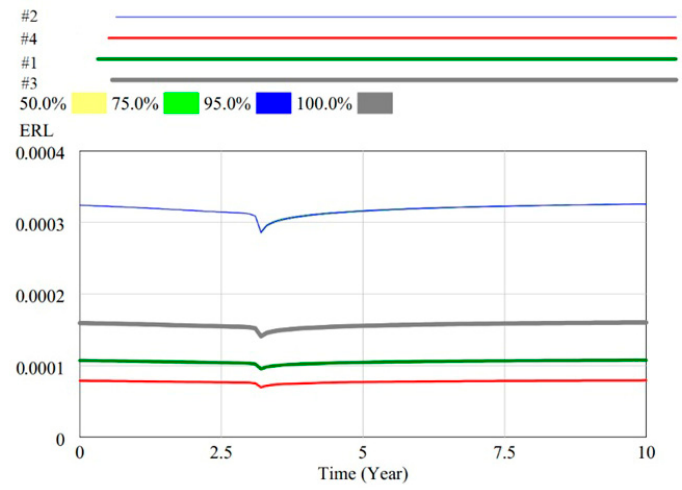
Figure 21. SD sensitivity trace range under multivariate uncertainty—global risk over 10-year period for Case #1 to #4.